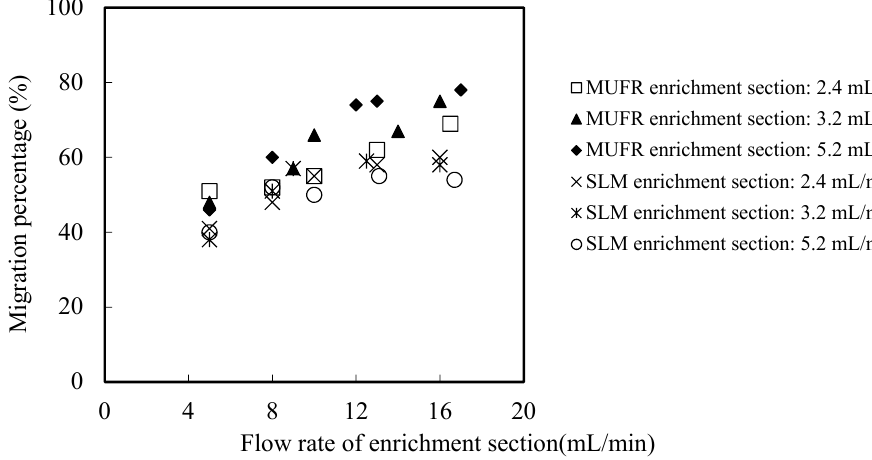
Figure 5. The comparison between MUFR and conventional SLM as regards flow velocity’s effect on migration of praseodymium(III) in both sections (I).